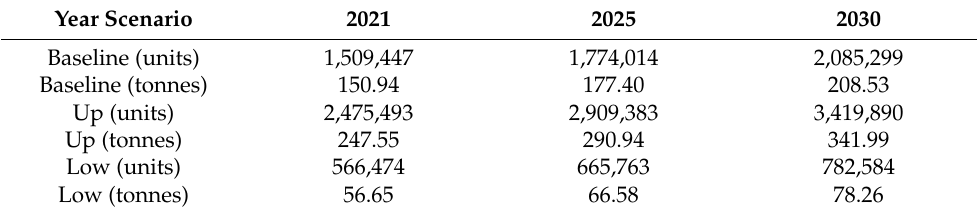
Table 9. Waste mobile phones estimation for baseline, up, and low